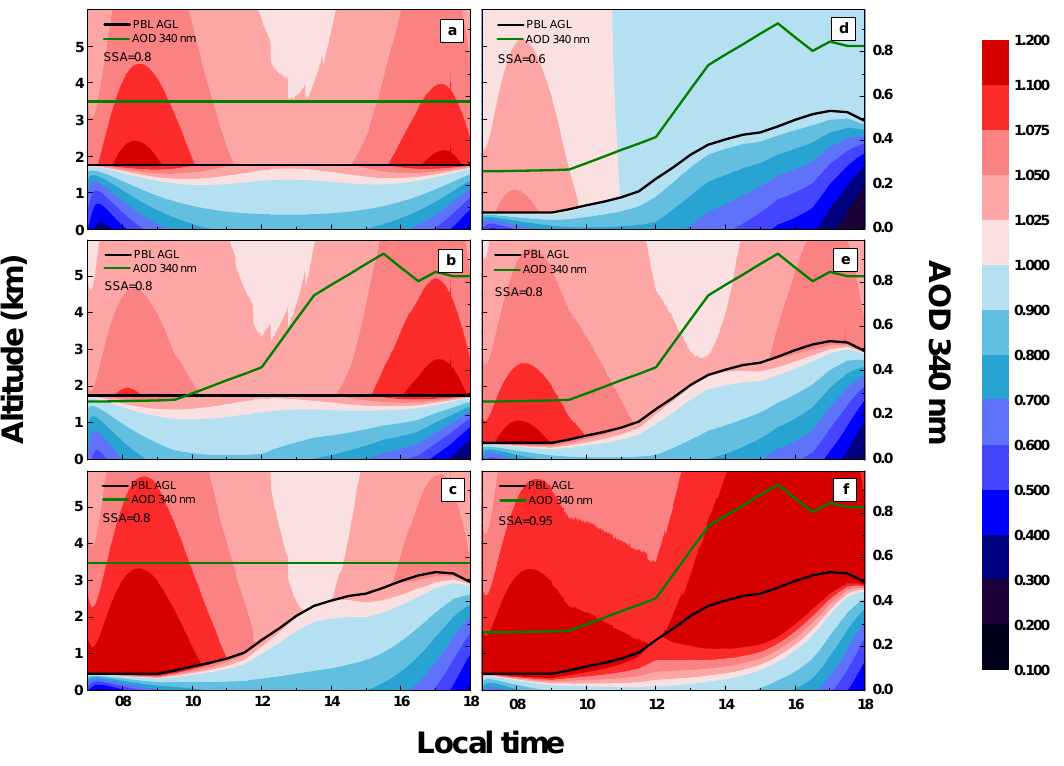
Fig. 9. Hourly variation of the ratios between polluted (only aerosols) and clear-sky total actinic flux model calculations for 10 March 2006 at all altitudes below 6km (a.g.l.). (a) Constant AOD340 and PBL altitude; (b) constant PBL altitude; (c) constant AOD340; (d) SSA = 0.6; (e) SSA = 0.8; (f) SSA =